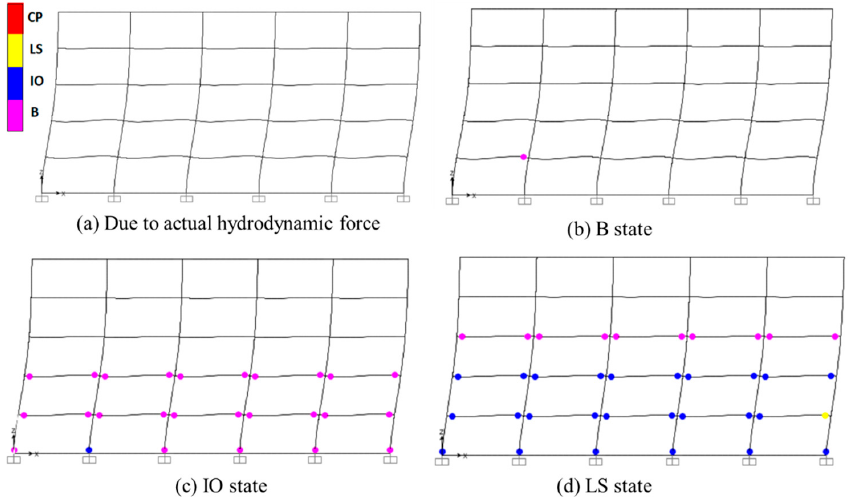
Figure 9. Deformation of the building and plastic hinge formation for cases Ia and Ib.